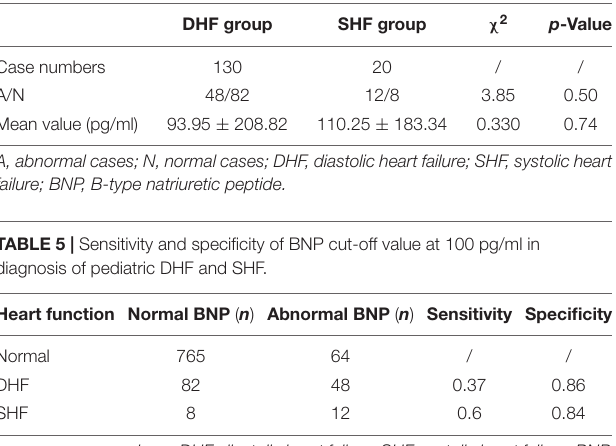
Frontiers in Pediatrics |